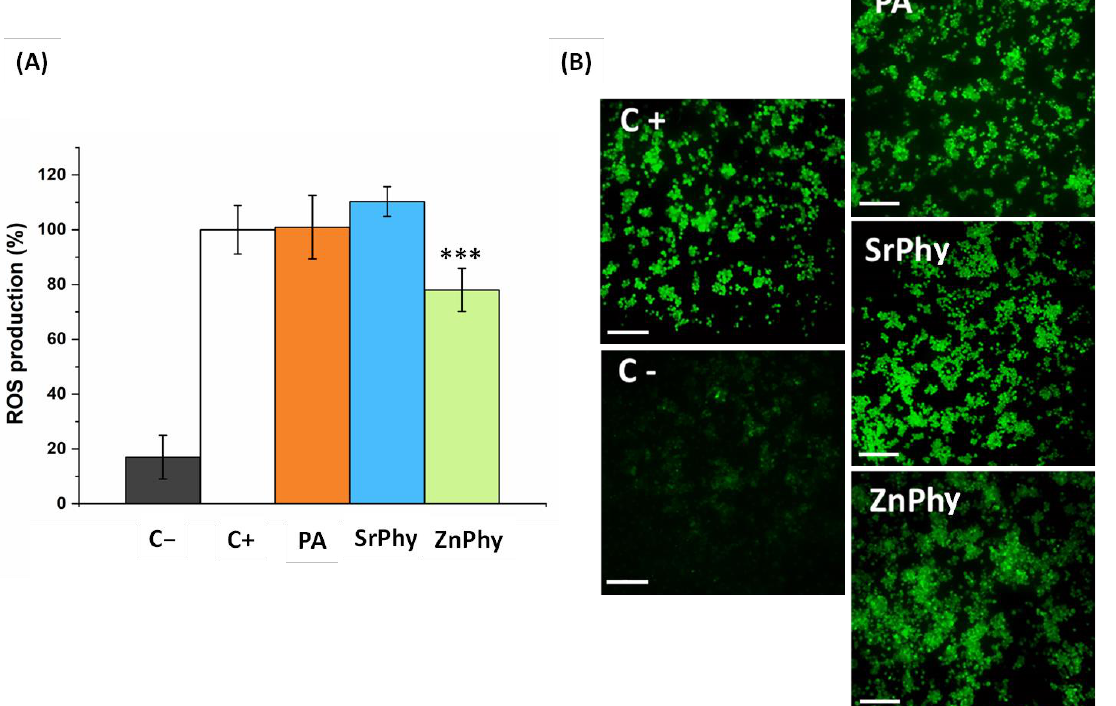
Figure 4. ( A ) Quantitative analysis of ROS production by RAW264.7 cultures. The results were expressed relative to the positive control, which was referred to as 100% ROS production. An ANOVA test was performed between samples at the significant level *** p < 0.001 (Tukey ’s test). ( B ) Fluorescence microscopy images were obtained for positive and negative controls (left), and PA, SrPhy and ZnPhy samples (right). Scale bars correspond to 100 µm. The positive control refers to cells stimulated with H 2 O 2 and the negative control corresponds to untreated cells. The results are presented as the mean ROS production (%) ± SD ( n = 8).